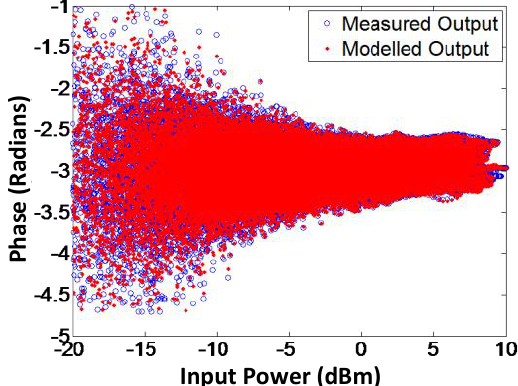
Figure 10. AM-PM characteristics of modeled and measured output signals for the branch-by-branch digital combining architecture, showing that the proposed technique is able to model the phase response efficiently.